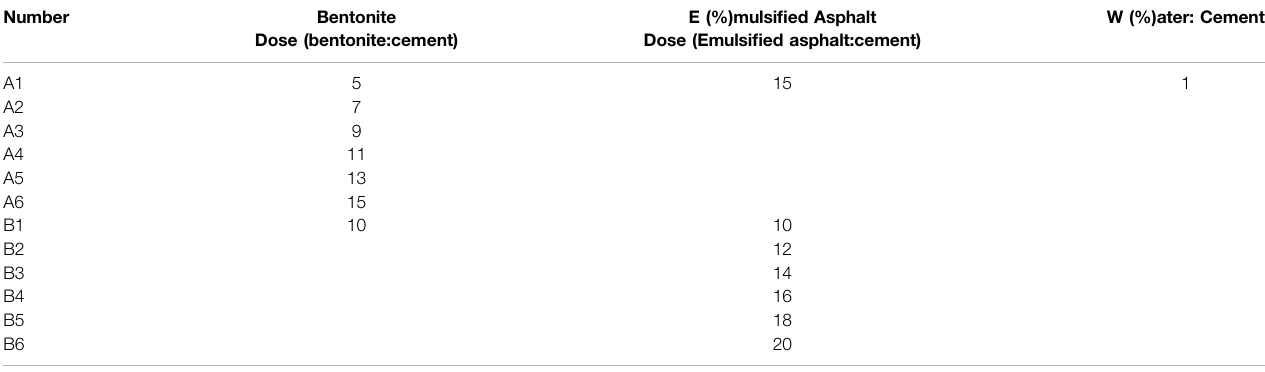
TABLE 2 | Testing scheme with different modi fi ers. Number Bentonite Dose (bentonite:cement)